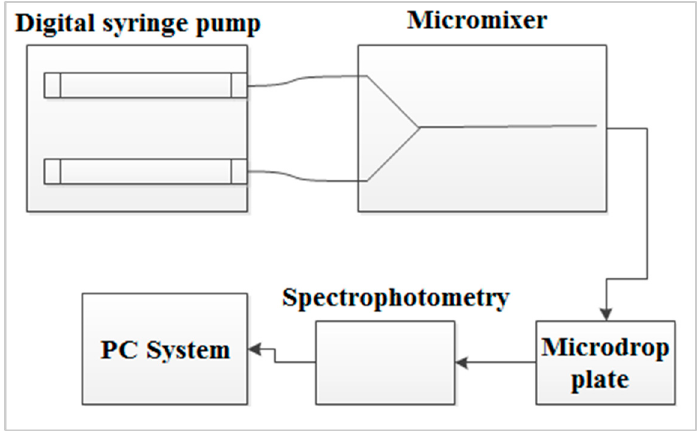
Figure 5. O ff chip absorbance measurement. Figure 5. Off chip absorbance measurement. Figure 5. Off chip absorbance measurement.